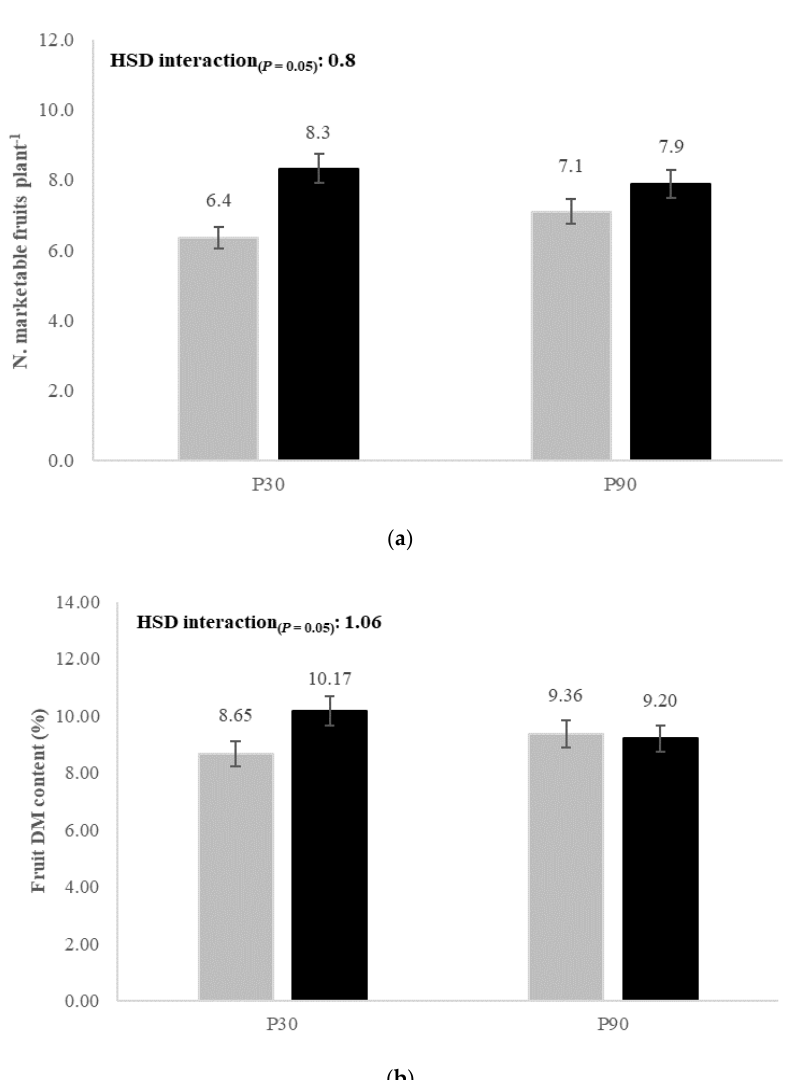
Figure 2. Number of marketable fruits plant −1 ( a ) and fruit DM content ( b ) as affected by ‘phosphorus level × rootstock’ interaction. Grey bars: ungrafted; black bars: grafted onto ‘Espina’.